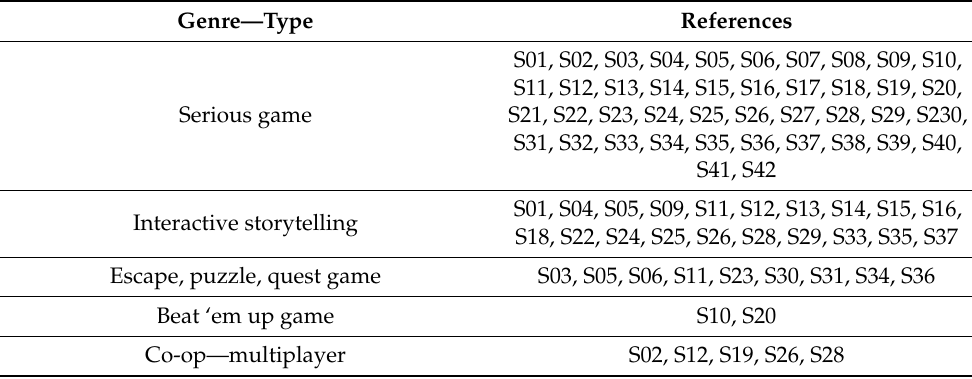
Table 6. VR game types (selected